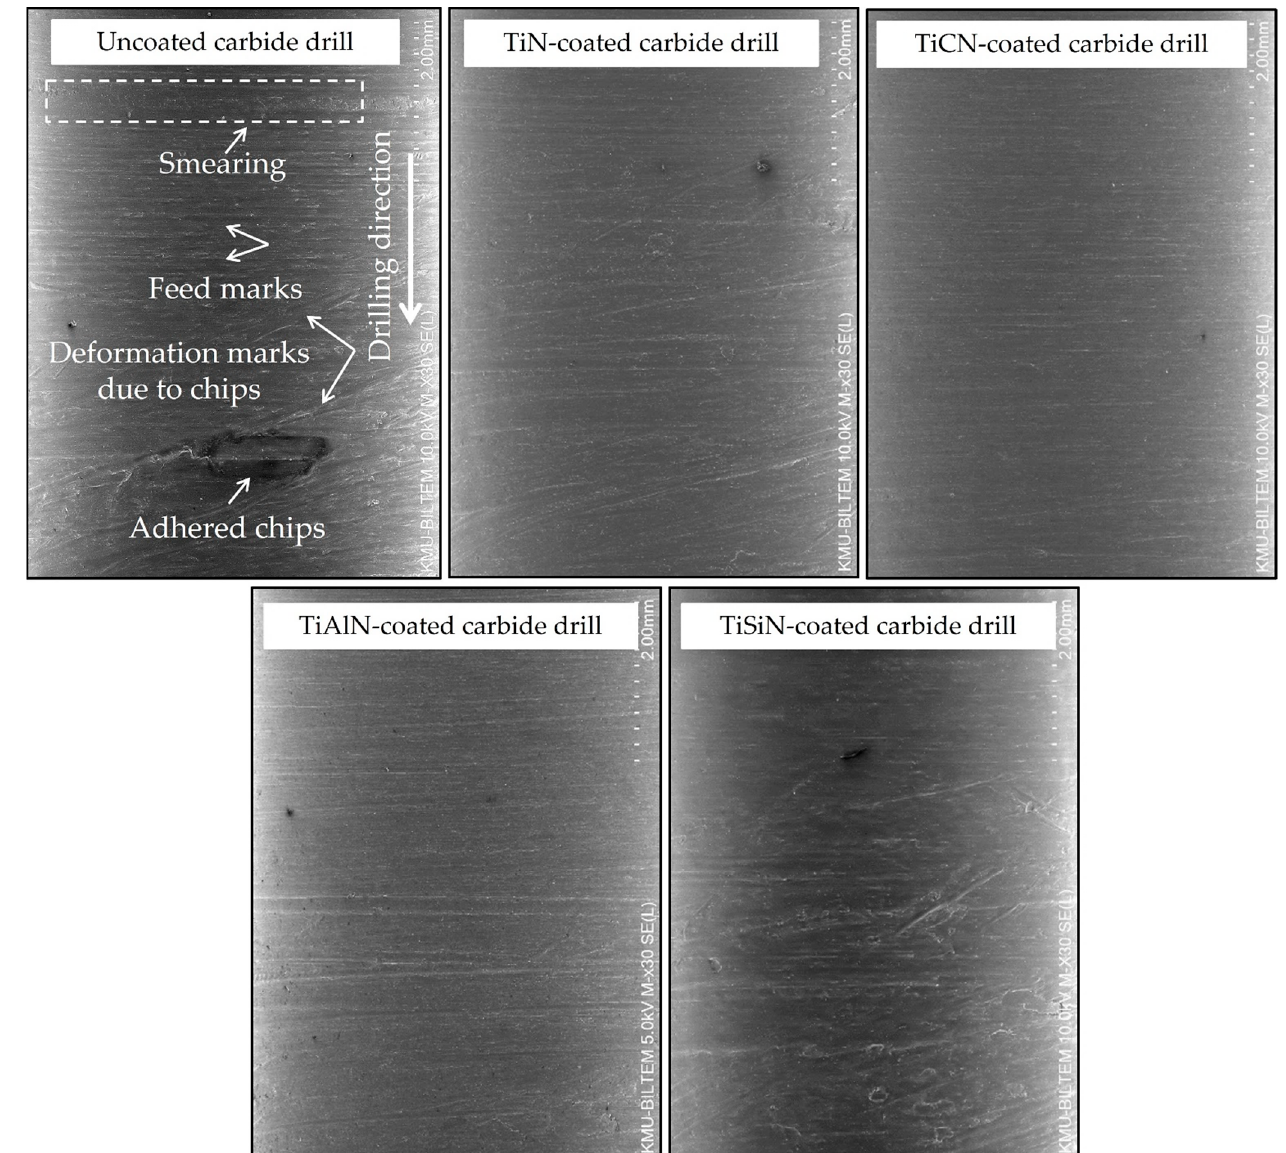
Figure 6. Inner hole surface of Al2024 using uncoated carbide and coated carbide drills at 3025 rpm and 0.14 mm/rev.